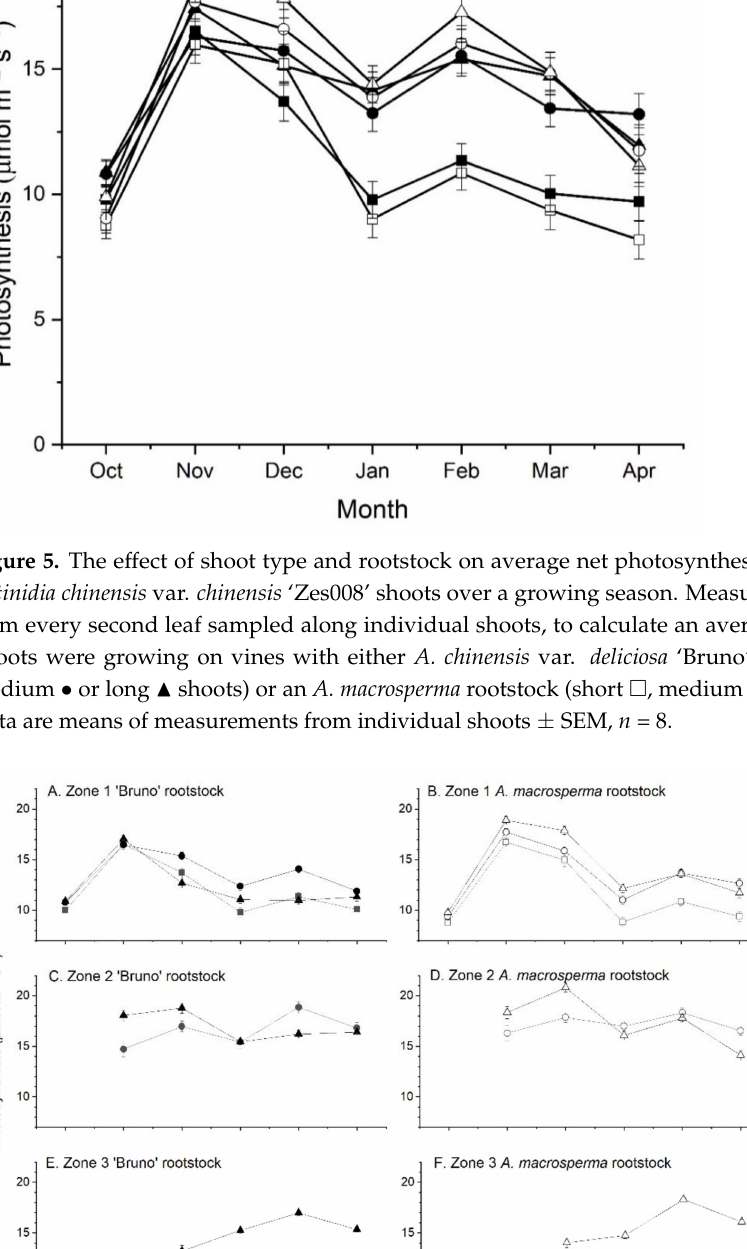
Figure 6. The effect of shoot type and rootstock on the net photosynthesis rate with leaf zone position on shoots of Actinidia chinensis var. chinensis ‘Zes008’ over a growing season ( A ) A. chinensis var. deliciosa ‘Bruno’ rootstock Zone 1—leaves 1–9 ( B ) A. macrosperma rootstock Zone 1, ( C ) A. chinensis var. deliciosa ‘Bruno’ rootstock Zone 2—leaves 10–18, ( D ) A. macrosperma rootstock Zone 2, ( E ) A. chinensis var. deliciosa ‘Bruno’ rootstock Zone 3—leaves 19 and greater and ( F ) A. macrosperma rootstock Zone 3. Shoot types are identified by A. chinensis var. deliciosa ‘Bruno’ rootstock (short (cid:4) , medium • or long (cid:78) shoots) or an A. macrosperma rootstock (short (cid:3) , medium or long (cid:52) shoots). Data are means across (cid:35) each zone and shot type × rootstock combination ± SEM, n =